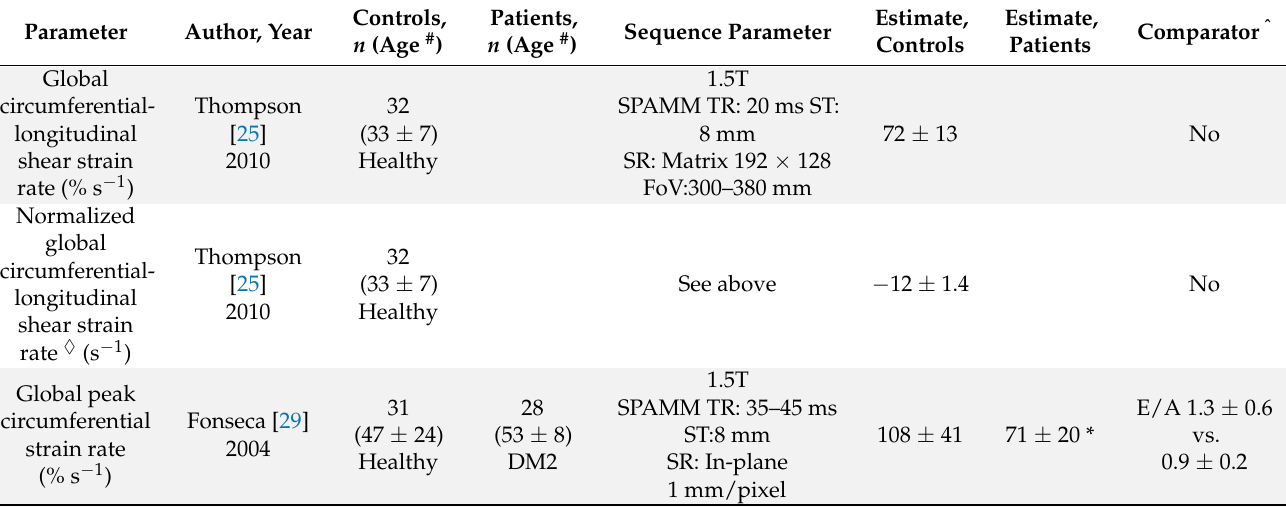
Table 2. CMR tagging—diastolic strain